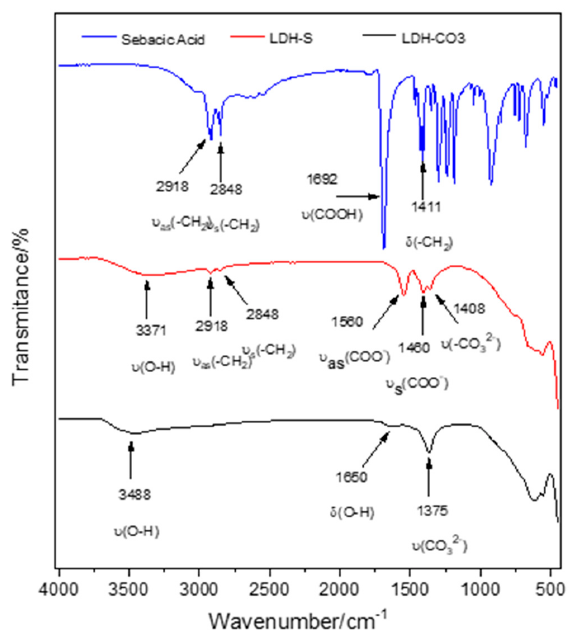
Figure 3. FT-IR spectra patterns of LDH-CO 3 and LDH-S.